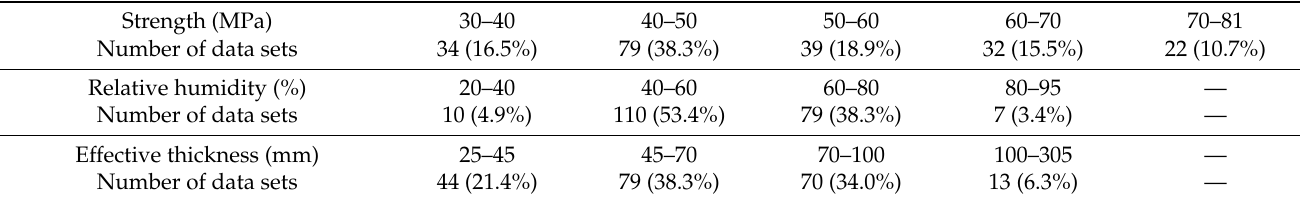
Table 1. Distribution of major parameters of the shrinkage